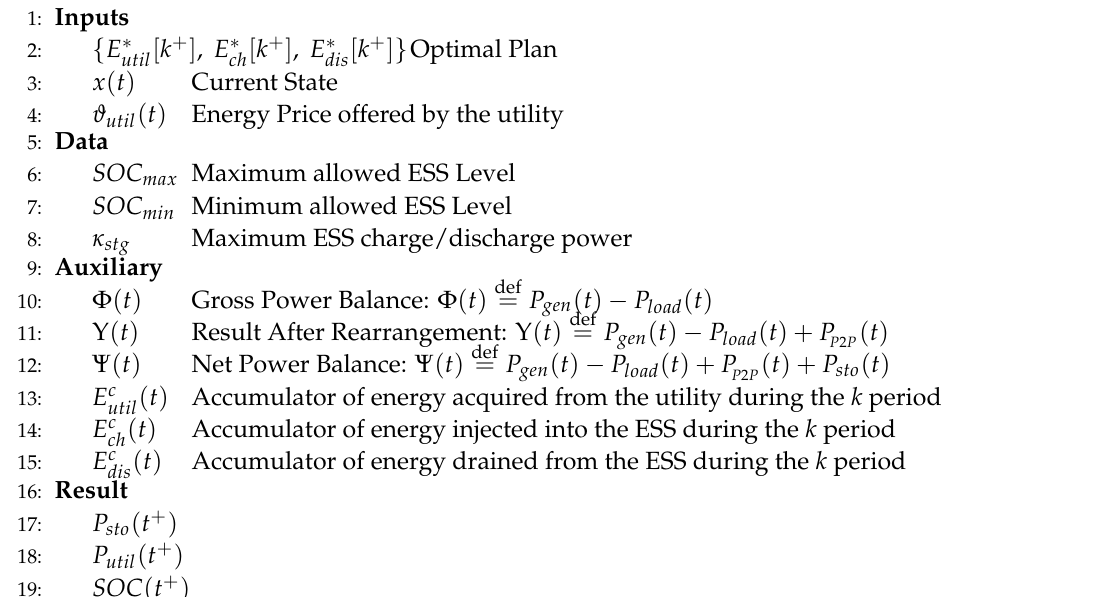
Algorithm 1 Demand Satisfaction Algorithm with Integrated Markets for peer